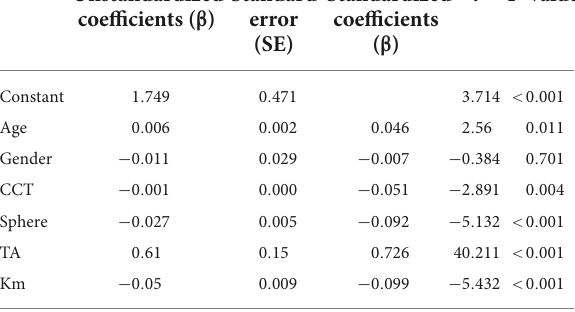
TABLE 3 Multiple linear regression model estimating the correlation between age, gender, central corneal thickness, sphere, corneal curvature, and corneal